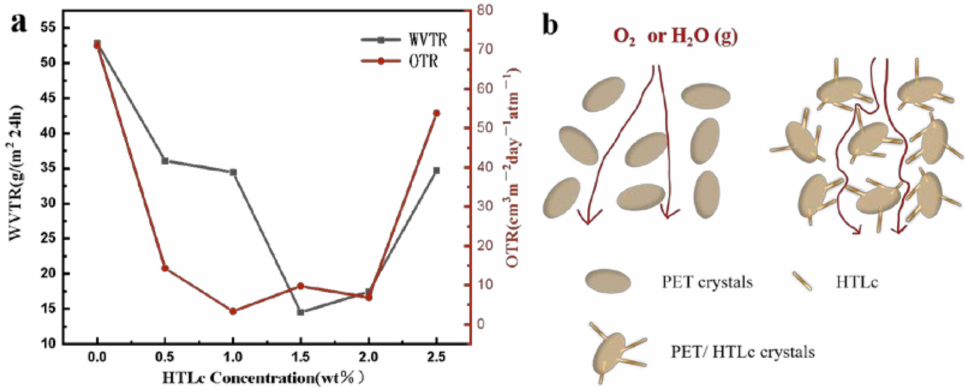
Figure 3. Barrier to oxygen and water vapor. ( a ) Water vapor transmission rate (WVTR) and oxygen transmission rate (OTR) curves for a series of PET/HTLc films ( b ) Illustration of the gas barrier film of the PET/HTLc